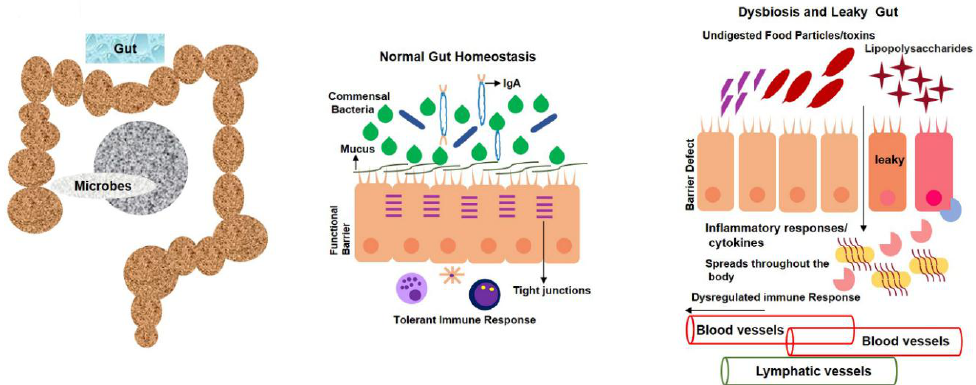
Figure 4. Leaky gut contributes to circulatory inflammagens and proinflammatory cytokines. Opportunistic bacteria produce various toxins and polysaccharides that, in turn, cause intestinal-wall inflammation that results in a leaky gut. Epithelial-cell inflammation also leads to loss of tight junctions that provide opportunities for undigested food particles, toxins, and inflammatory cytokines to enter bloodstream. Toxins and lipopolysaccharide (LPS)-containing blood later enter brain via blood–brain-barrier disruption.